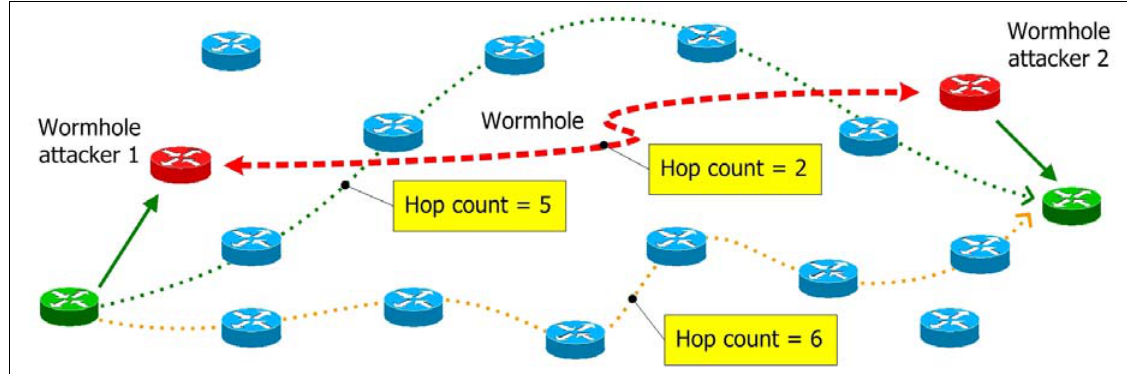
Figure 2. Distinguishing safe routes from hop-count values.